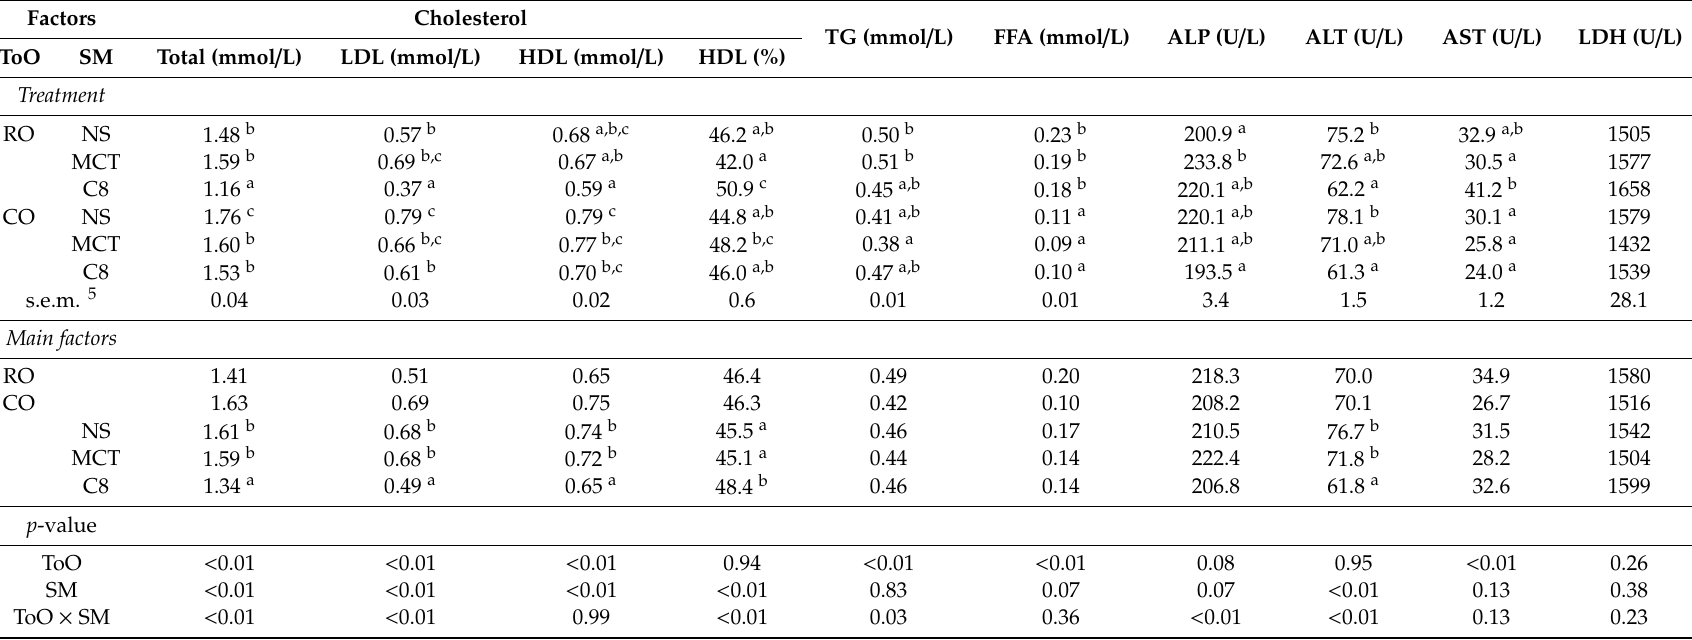
Table 10. Biochemical indices in serum of piglet at 60th day of